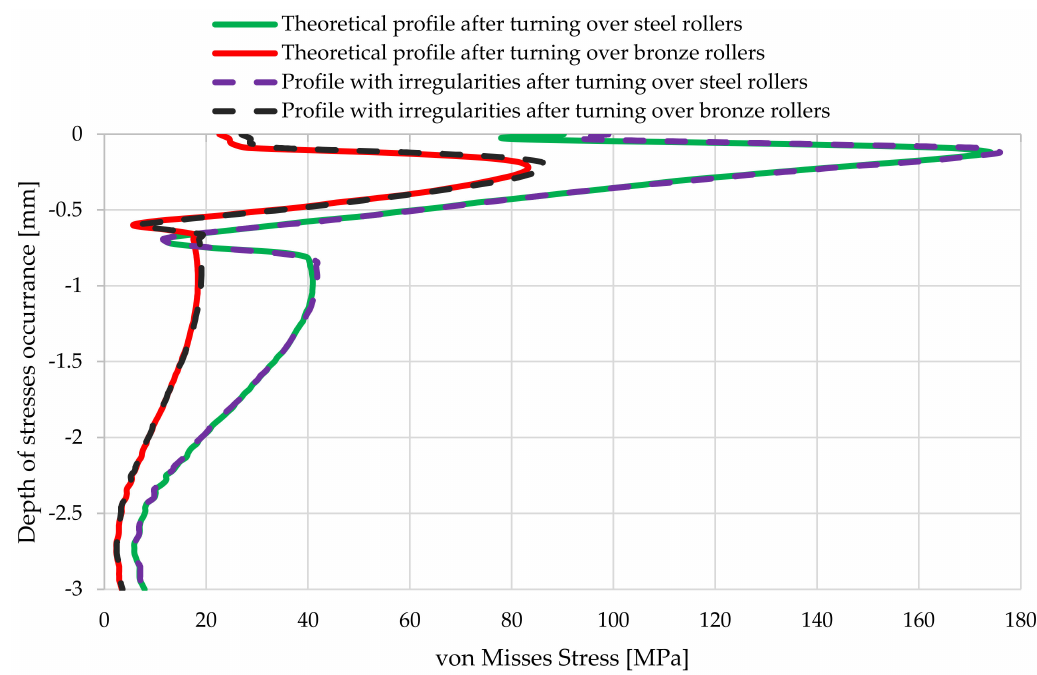
Figure 20. Graphs of von Mises stresses remaining in the steel shaft journal as a function of the depth of their occurrence, for the “zero” position at the reaction force of R = 4000 N for the journal profile not burdened with outline irregularities and the actual one, after turning these outlines on a steel support roller and a support roller made of